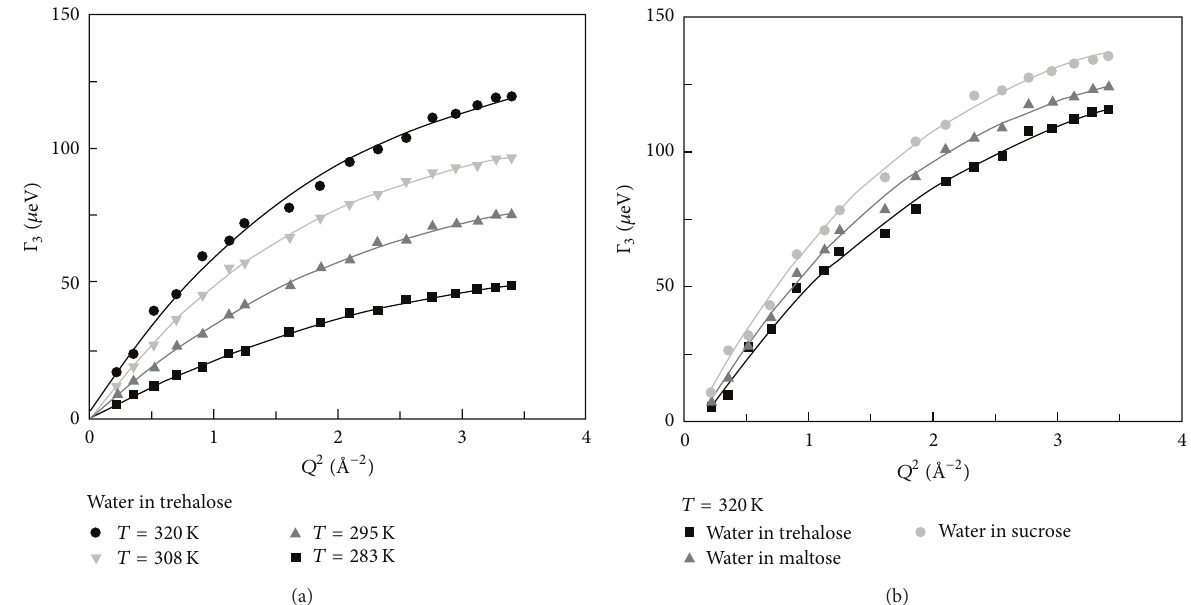
Figure 2: Translational linewidth Γ 3 of (a) water in trehalose solutions for different temperature values and of (b) water in trehalose, maltose, and sucrose aqueous solutions at 𝑇 = 320 K as a function of 𝑄 2